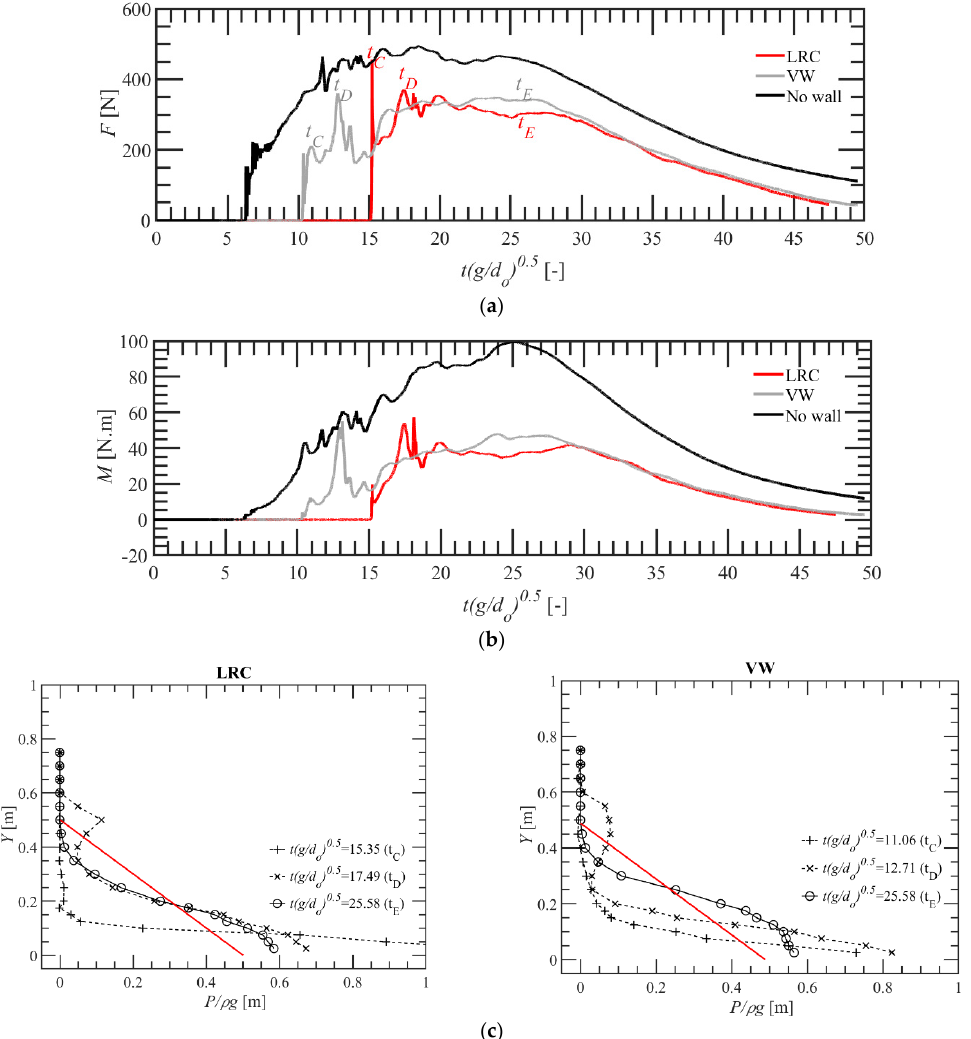
Figure 12. ( a ) Force acting on the inland structure in the presence of a mitigation wall (Wall 4; L = 1 m and d o = 0.9 m); ( b ) moment–time history; ( c ) pressure distribution over structure depth. The flow interaction presented in Figures 10 and 11 at different time steps is also marked. The solid red line in Figure 12c represents the hydrostatic pressure calculated with bore depth at the structure front at time instant ‘ t E ’ mentioned in Figure